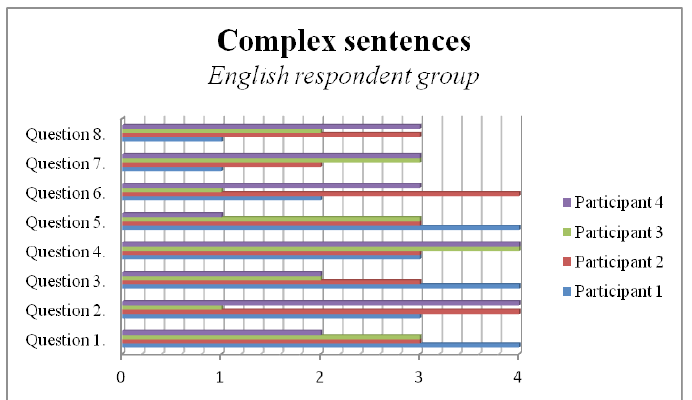
Graphic 11: Compound sentences - Spanish respondent group. Compound sentences present likewise a spectrum from 2 through 5 in the English group, and from 2 through 4 in Spanish.